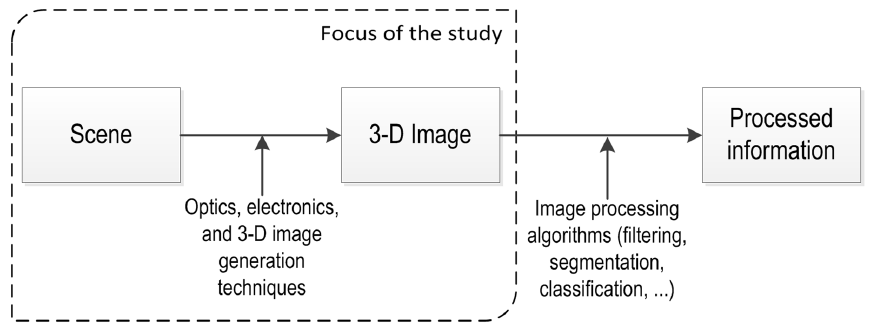
Figure 1. The 3-D image generation techniques are critical for generating robust raw data for useful information extraction. information